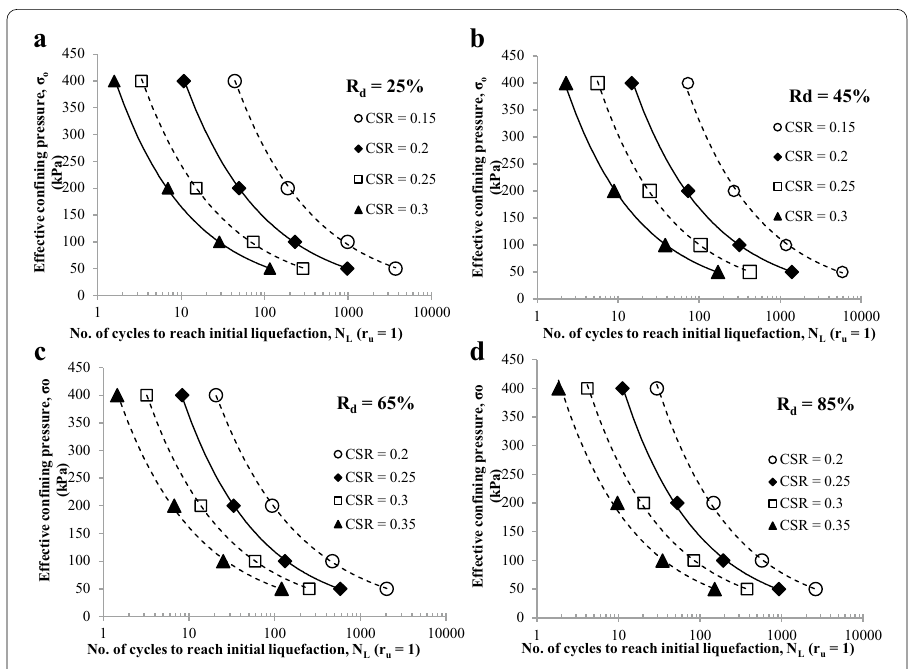
Fig. 13 Effect of confining pressure on number of cycles to liquefy for different cyclic stress ratios at a R d 25%; b R d 45%; c R d 65% and d R d = = = =